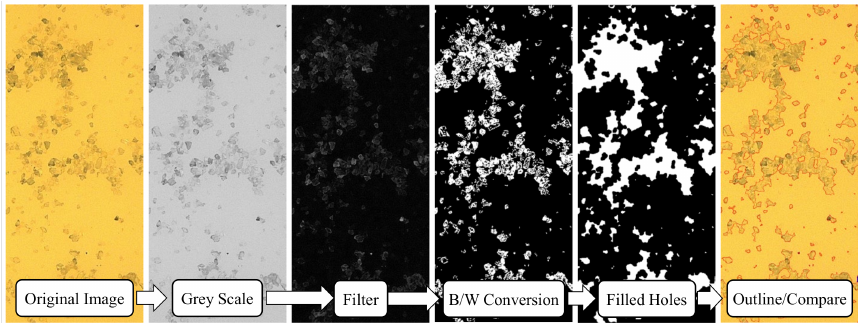
Figure 12. Flowchart of the fouling analysis algorithm (images were truncated for